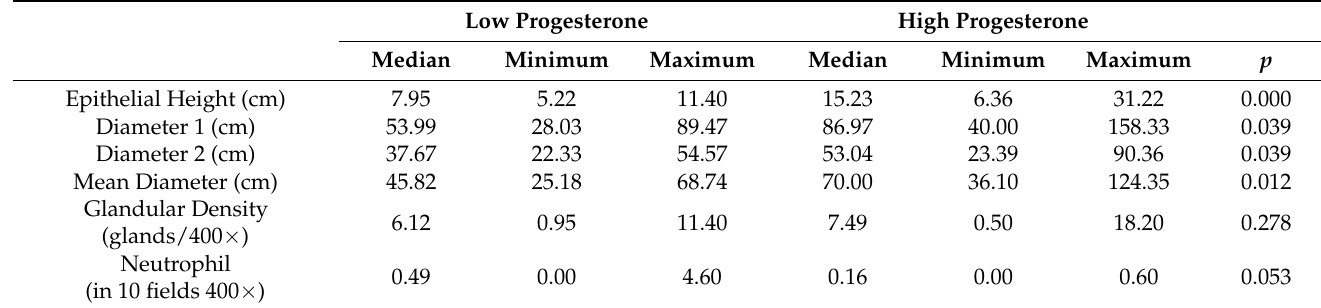
Table 4. Results for histological examination. Values are expressed as the median plus the minimum and maximum. Low Progesterone High Progesterone Median Minimum Maximum